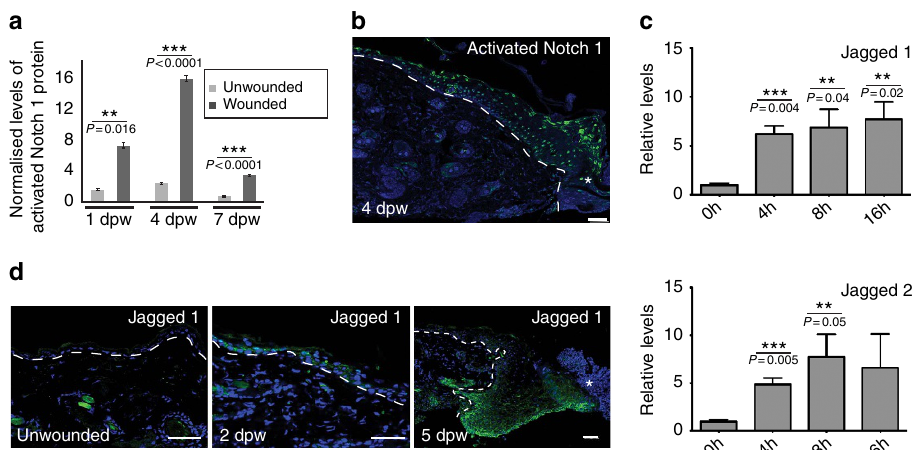
Figure 1 | Notch1 is activated in wounded skin; the Notch ligands Jagged1 and Jagged2 are upregulated in response to injury. Back skin tissues from punch-wounded wildtype mice were collected 4, 8, 16h and 1, 2, 4, 5 and 7 dpw. ( a ) Graph summary of cleaved, activated Notch1 protein levels quantified by antibody detection in a western immunoblotting assay (Supplementary Fig. 9a). Notch1 levels were standardized to b -actin levels as a loading control and normalized to Notch1 levels (designated as 1) in uninjured littermate mice. Unwounded back skin was taken from a punch-wounded mouse at a distal site (minimum 2cm) from wound site. n ¼ 3 biological replicates each time point post wounding. Normally-distributed data was compared by Student’s t - test between wounded and unwounded samples. ( b ) Section stained with antibodies specific for activated Notch1 on tissue collected 4 dpw. Note activated Notch1 is detectable in all epidermal layers. ( c ) mRNA levels of Jagged1 or Jagged2 quantified by qPCR in unwounded (0h) and wounded back skin 4, 8, 16h (h) post wounding. mRNA levels were normalized to UW. ( d ) Sections were stained for anti-Jagged 1 (green) on unwounded, 2 and 5 dpw. White asterisks ( b , d ) mark wound site; white dash line denotes epidermal/dermal boundary ( b , d ). Graph bars represent experimental mean of 3 or more biological replicates and error bars represent standard error of the mean (s.e.m.); Results statistically significant marked with ** or ***; P -values included on graphs. Scale bars equal 50 microns. All experiments were repeated Z 2